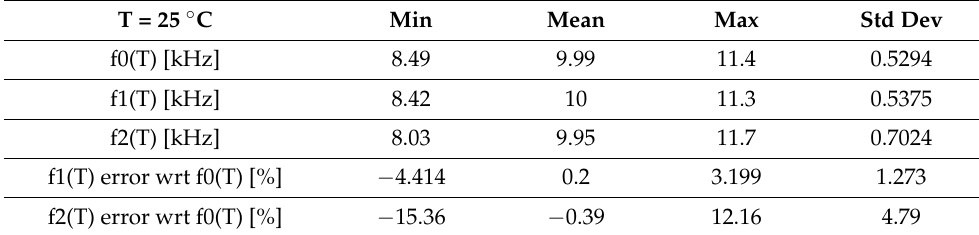
The relative deviations of the oscillation frequencies f1(T) and f2(T) with respect to the ideal-supply case, f0(T), were computed for each Monte Carlo simulation run. Statistical data on the resulting relative errors are listed in the last two rows of Table 1. This allows one to analyze the error caused by the LDOs separately from the intrinsic error of the